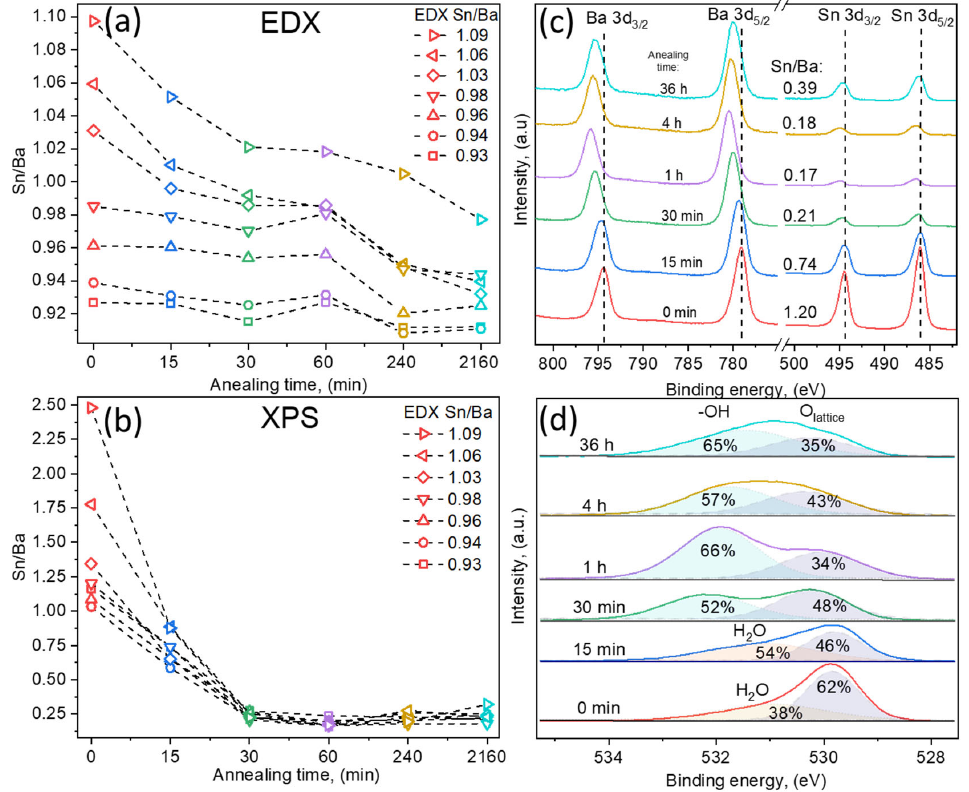
Figure 3. Composition dependency on annealing time of LBSO films with Sn/Ba ratios of 0.93, 0.94, 0.96, 0.98, 1.03, 1.06, and 1.09 as determined using EDX. Samples are named using the initial Sn/Ba ratio determined using EDX as a reference. ( a ) Bulk thin LBSO film Sn/Ba ratio dependency on annealing time measured using EDX. ( b ) Surface Sn/Ba ratio at different annealing times determined using X-ray photoelectron spectroscopy. ( c ) High-resolution Ba 3d and Sn 3d XPS spectra of LBSO film with an initial Sn/Ba ratio of 0.98. ( d ) High-resolution O 1s XPS spectra dependency on annealing time of LBSO sample with Sn/Ba ratio of 0.98.